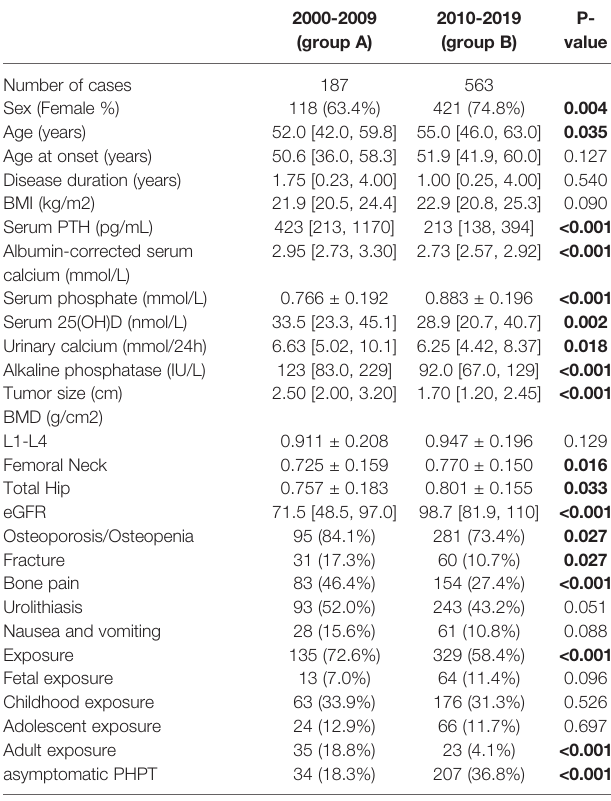
TABLE 1 | Changes over time in demographic, clinical fi ndings and famine exposure in patients with PHPT from